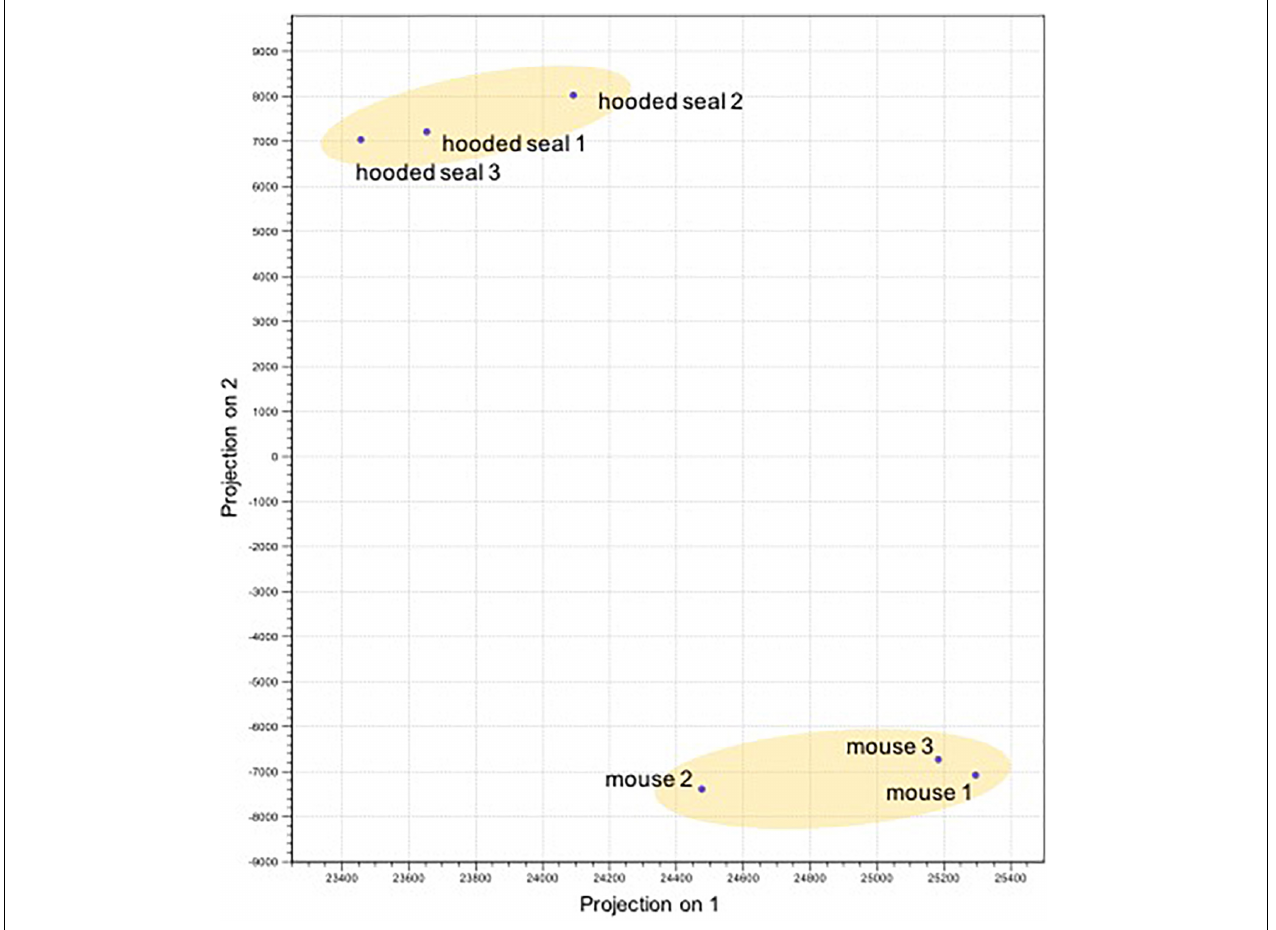
FIGURE 1 | Principal component analysis of the differentially expressed genes (normalized expression values) of the neurons in the visual cortex of hooded seals ( Cystophora cristata , n = 3 ) and mice ( Mus musculus , n = 3).